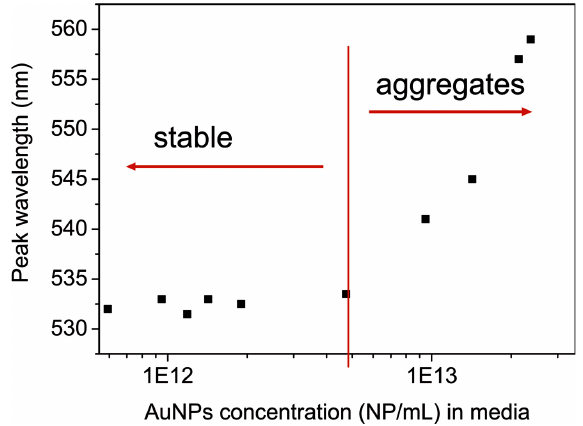
Figure 3 . Stability in cell culture media (DMEM + 10 % FBS) of increasing concentrations of MUA capped AuNPs. AuNPs are not stable at concentrations above 4.75 (cid:3) 10 12 NP/mL of cell culture red-shift of the SPR band. On the other hand, stability is protein